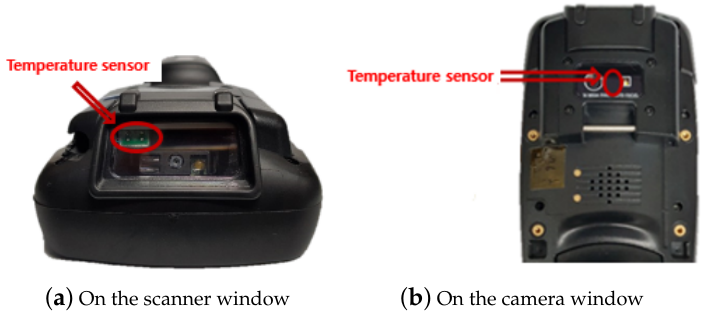
Figure 8. Temperature sensors on the test platform